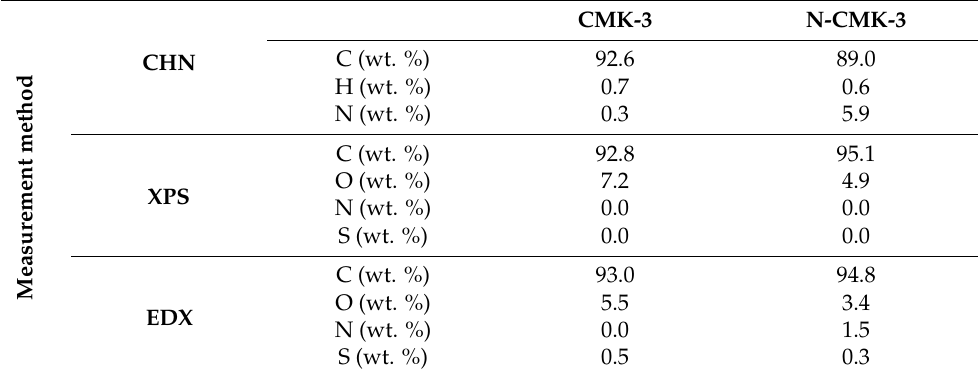
Table 2. CHN, XPS and EDX elemental analysis results for CMK-3 and N-CMK-3.